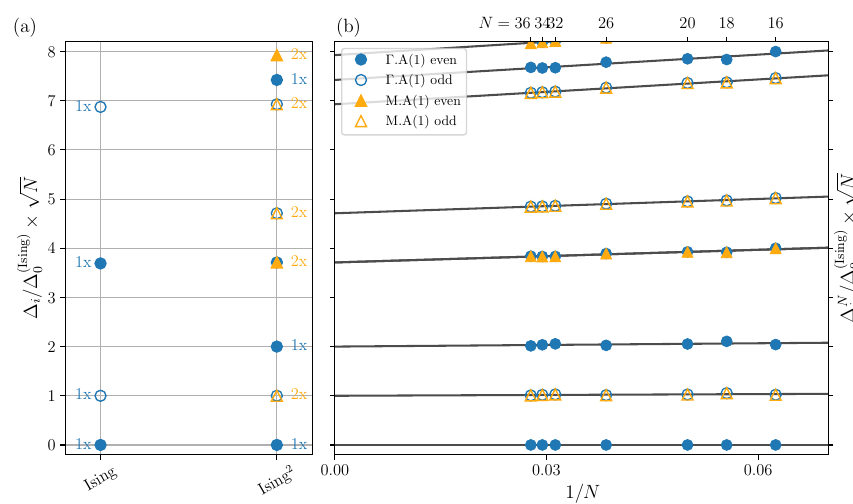
= 0 for κ = 0 levels only. The CTES AT . (a) Ising 2 CTES S (cid:112) × N of the AT-TFI model at i